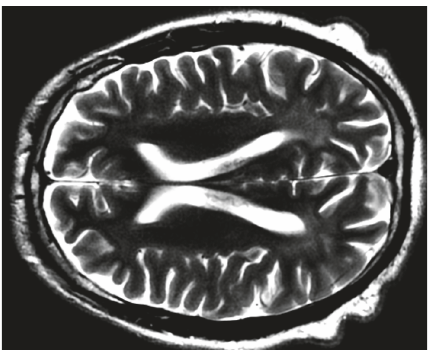
Figure 3: Bilateral hyperintensities in T2 in the occipitoparietal white matter.